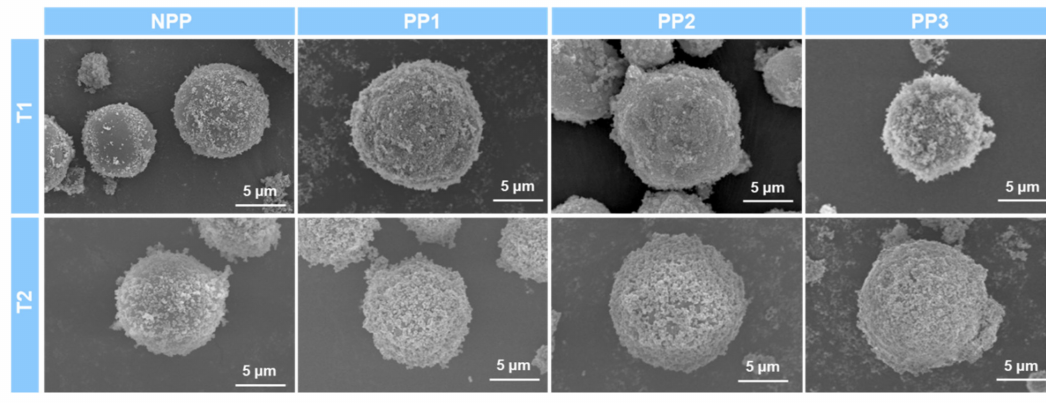
Figure 4. FE-SEM images of hierarchical organic-inorganic hybrid particles.